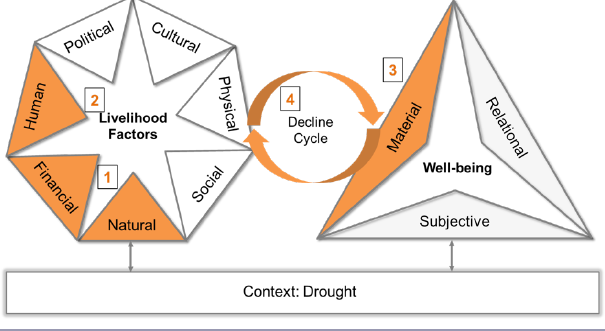
Fig. 4 . The integrated sustainable livelihoods approach and well-being framework for northeastern Colorado livestock producers capturing a multi-factor cycle of decline, with orange depicting losses. (1) First, the operation was hit with drought, further challenging the financial factor. (2) The financial and natural losses influenced a loss of pride or subjective well- being. (3) This loss of financial, natural, and subjective well- being affected a decline of material well-being. (4) Last, these losses sparked the system transforming cycle of decline and migration out of agriculture.